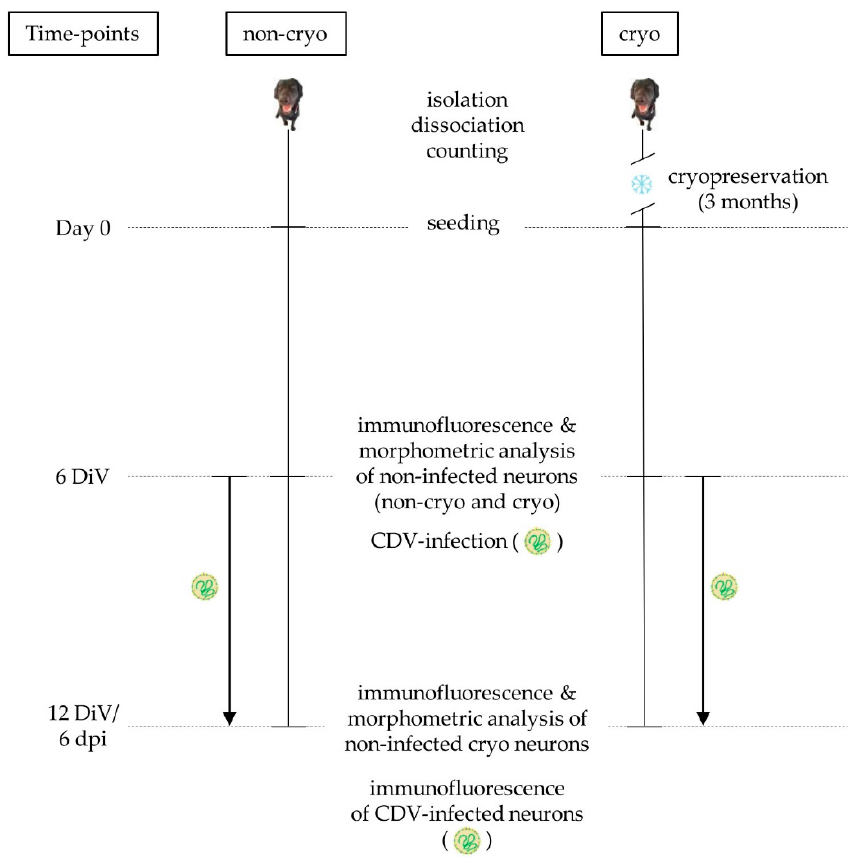
Figure 6. Experimental design: while non-cryo neurons were directly seeded after isolation, dissociation and counting, cryo-neurons were cryopreserved an thawed after 3 months. The day the neurons were seeded represents day 0 of the experiment. Part of the cultures were fixed for comparative immunofluorescence and morphometric analysis at 6 DiV for non-cryo and cryo neurons and at an additional time-point (12 DiV) for cryo neurons. The remaining DRG neuronal cultures were infected with 2 different strains of CDV (CDV-5804 PeGFP, CDV R252) at 6 DiV and kept in culture until 12 DiV or 6 dpi, respectively, when they were processed for immunostaining and further analysis. Non-cryo = non-cryopreserved neurons, cryo = cryopreserved neurons, DiV = days in vitro, dpi = days post infection, CDV = canine distemper virus, eGFP = enhanced green fluorescent protein.